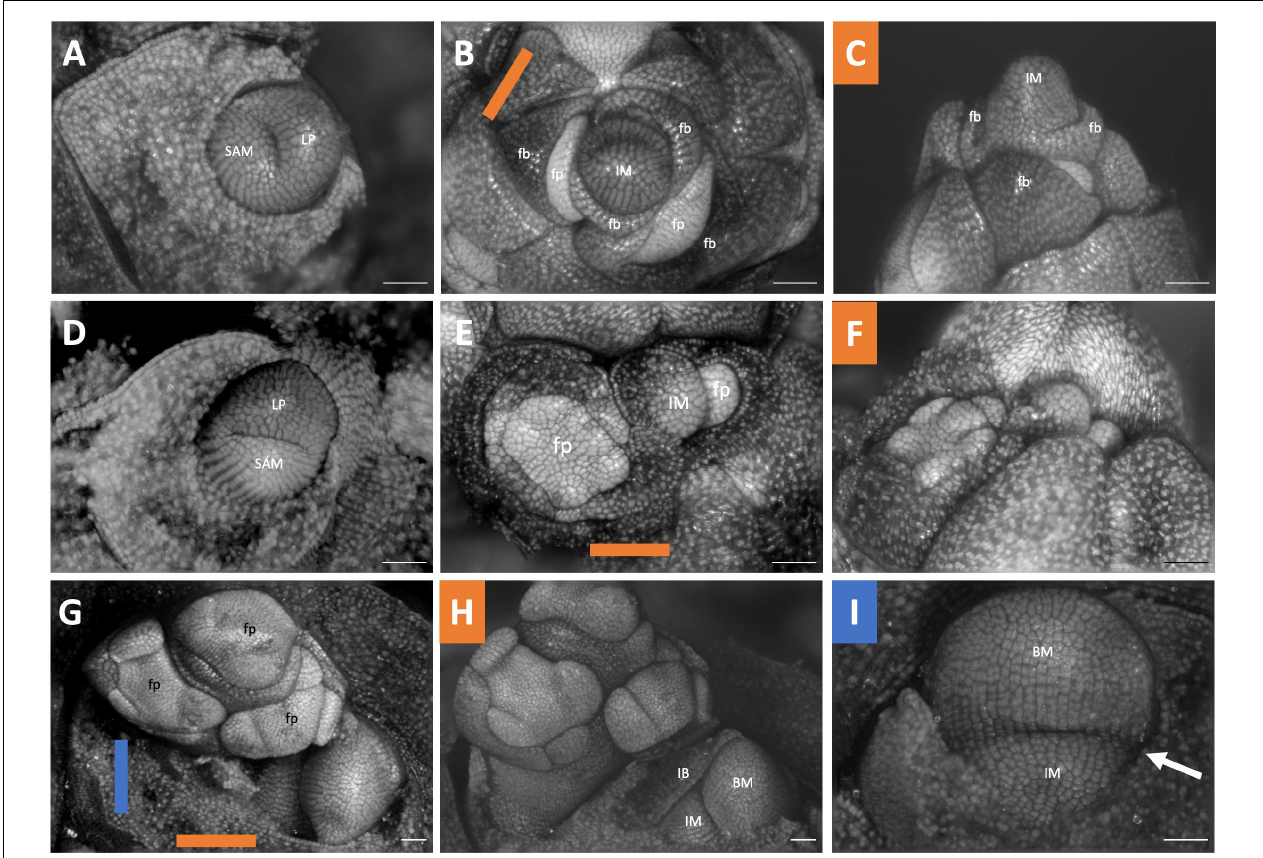
FIGURE 10 | Scilloideae inflorescence developmental morphology. (A–C) Ornithogalum nutans (D–F) Ornithogalum umbellatum (G–F) Scilla siberica “ Alba ”. (A) Shoot Apical meristem. (B,C) young inflorescence imaged (B) apically (C) laterally. (D) Shoot Apical meristem (E,F) young inflorescence imaged (E) apically (F) laterally. (G) Young inflorescence imaged apically. (H) Imaged laterall y showing a racemic pattern of development of a branch (I) Inflorescence meristem with branching events. Colored lines on images taken from the apex (B,E,G) indicate orientation of the inflorescence in subsequent panels. SAM, shoot apical meristem; LP, leaf primordia; IM, inflorescence meristem; fp, floral primordia; fb, floral bract; IB, inflorescence bract; BM, branch meristem. Scale bar of all images: 100 µ